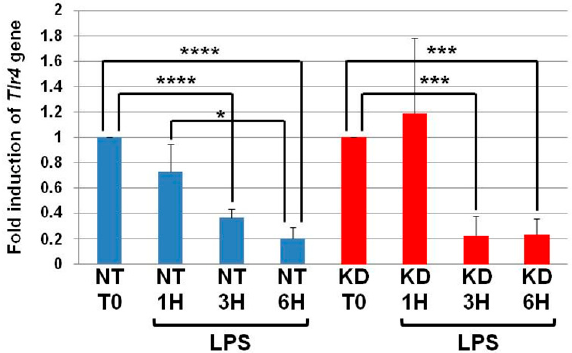
Figure 3. The levels of Tlr4 mRNA decrease in NT and PC1/3 KD macrophages challenged with LPS. NT and PC1/3 KD cells were challenged with 200 ng/mL of LPS for 0, 1, 3, and 6 h. The results are obtained from three independent experiments and depicted through graphic representations (means ± SD). Data were analyzed by the Student t -test and values of p < 0.05 are considered statistically significant (* p -value of <0.05, *** p -value of <0.001, **** p -value of <0.0001). 3.4. MYD88, the Key TLRs Signalling Adaptor, Displays a Potential Cleavage Site for Proprotein Convertases